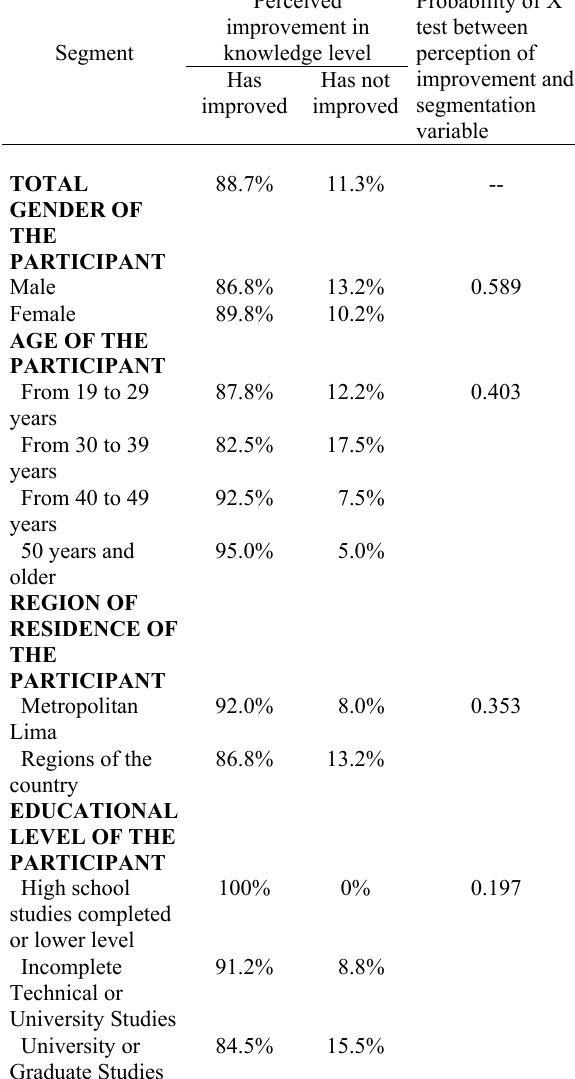
Table 2. Perception of improvement in the knowledge level of business topics after the participation in the